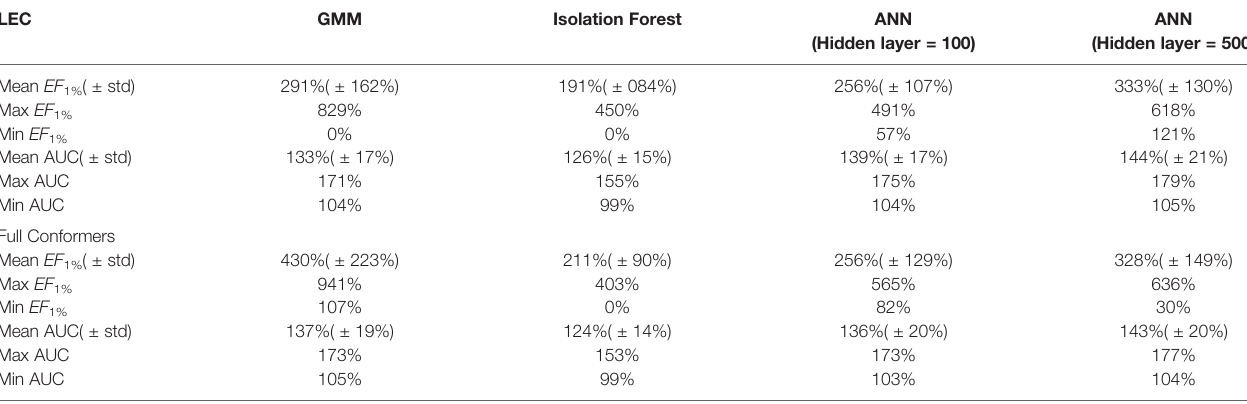
TABLE 2 | Summary of machine learning results expressed as percentage ratios over ElectroShape 5D. A value of 100% indicates that the same performance as ElectroShape 5D was obtained.